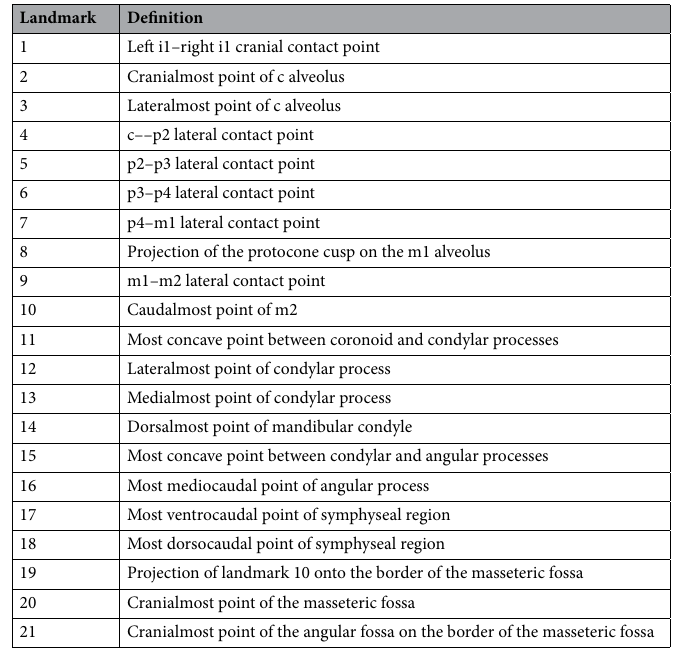
Table 4. Landmark definitions.